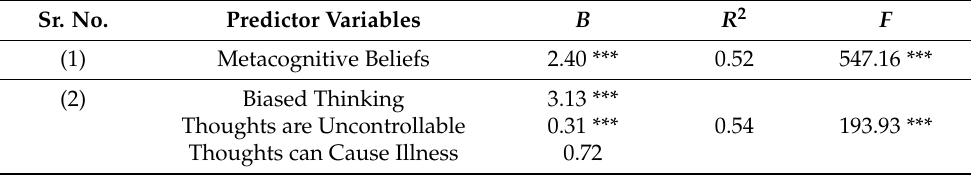
Table 3. Regression analysis of metacognitive beliefs and its constructs (biased thinking; thoughts are uncontrollable and thoughts can cause illness) as predictors of cyberchondria ( N = 500). Sr. No. Predictor